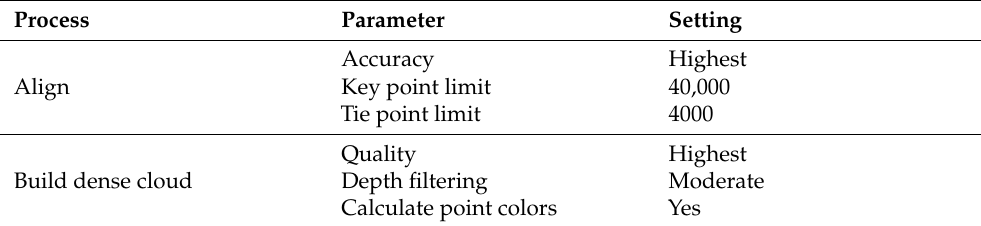
Table 2. The processing parameters used in the photogrammetric